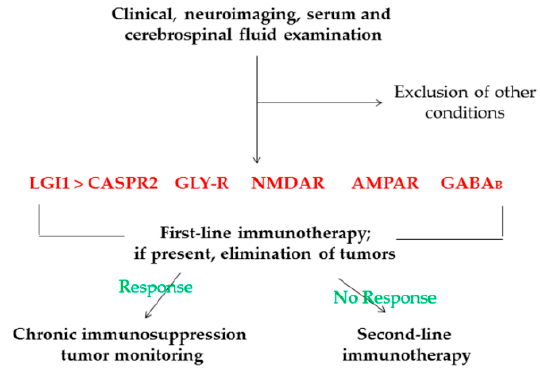
Figure 3. Diagnosis and treatment protocol after clinical, neuroimaging, serum, and cerebrospinal fluid examination with determination of specific antibodies and therapeutic decision with respect to response exerted after the first-line immunotherapy.